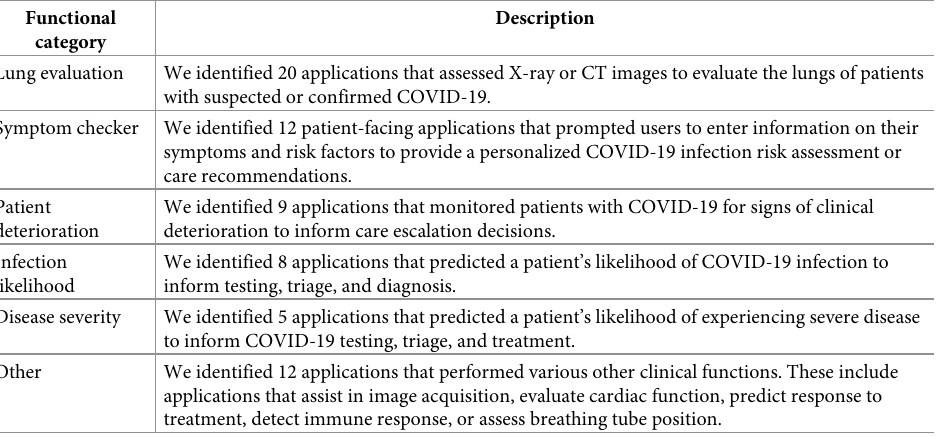
risk score (n = 4). All lung evaluation applications were used by clinicians in hospitals (n = 20), with some x-ray applications also used in mobile screening vans (n = 2), quarantine centers (n = 2), or border facilities and prisons (n = 1). Table 1. Summary of applications used in clinical response to